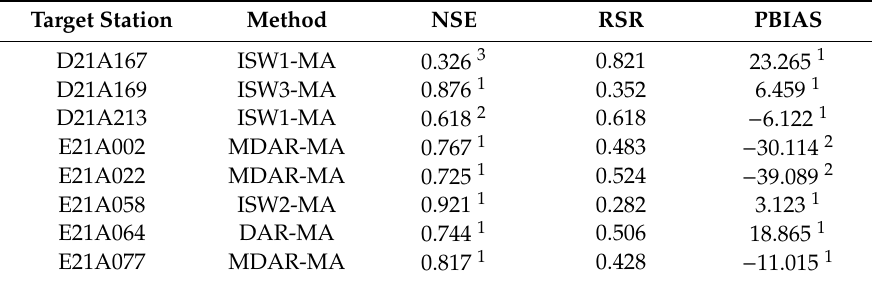
Table 10. Performance evaluation of the best statistical method with the MA for each target station in the Middle Euphrates